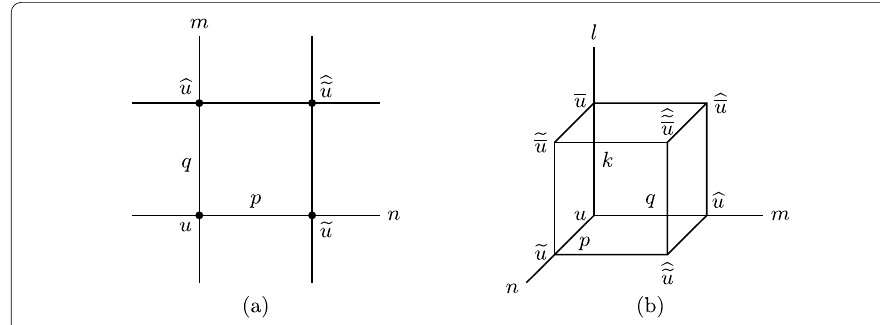
Figure 1 ( a ) Lattice on ( n , m ) plane. ( b ) Consistent